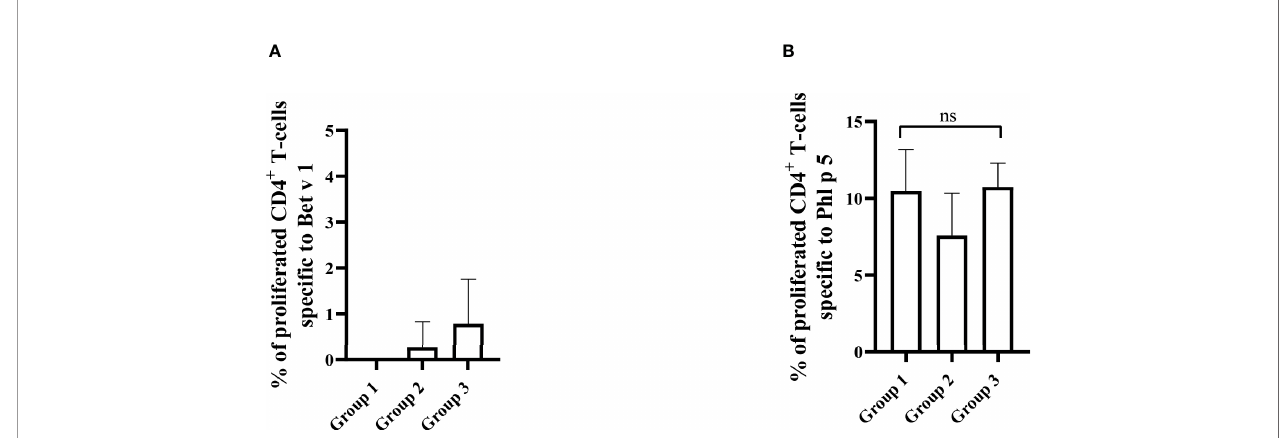
FIGURE 12 | Allergen-speci fi c T cell responses after fi ve prophylactic administrations of Bet v 1 peptides. Pooled splenocytes from the three mouse groups were labelled with CFSE and cultivated in the presence of 10µg of Bet v 1 (A) or 10µg of Phl p 5 (B) . T cell proliferative responses were analyzed by fl ow cytometry 5 days after culture and by gating on live CD3 + CD4 + T cells. Proliferated lymphocytes were assessed by loss of CFSE fl uorescence intensity. The experiments were performed in triplicates. Shown are the mean percentages of allergen-speci fi c proliferated CD4 + T cells after subtraction of the medium controls and SD. Data were analyzed by a general linear model with a log link, comparing group 1 and 3 by linear contrast. Statistically signi fi cant differences between group 1 and group 3 are indicated. ns, not signi fi